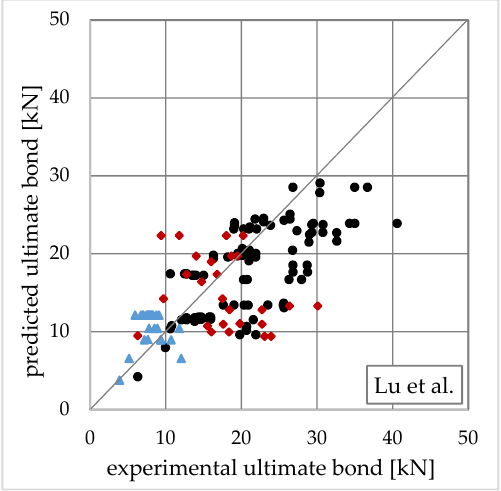
Figure 9. Test vs. predicted bond force using the Lu et al. model [21].